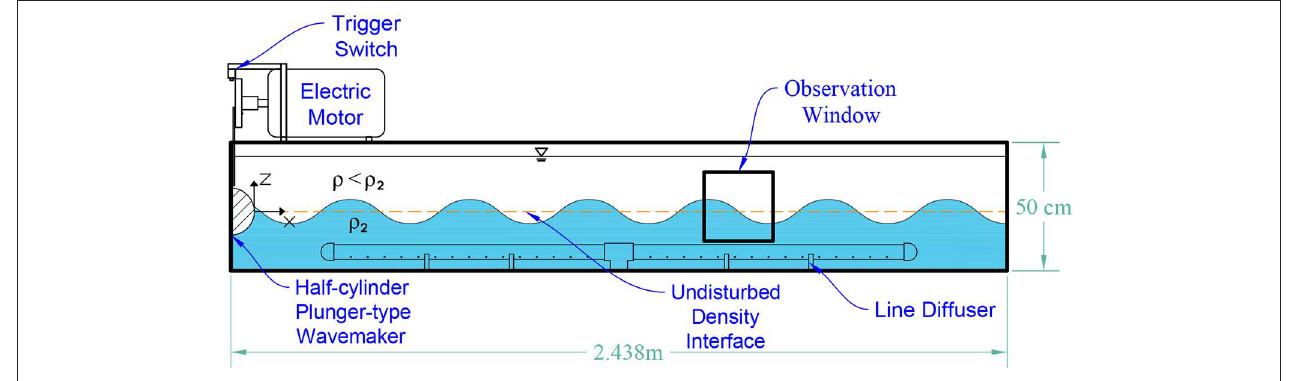
FIGURE 1 | Schematic diagram of the internal wavemaker